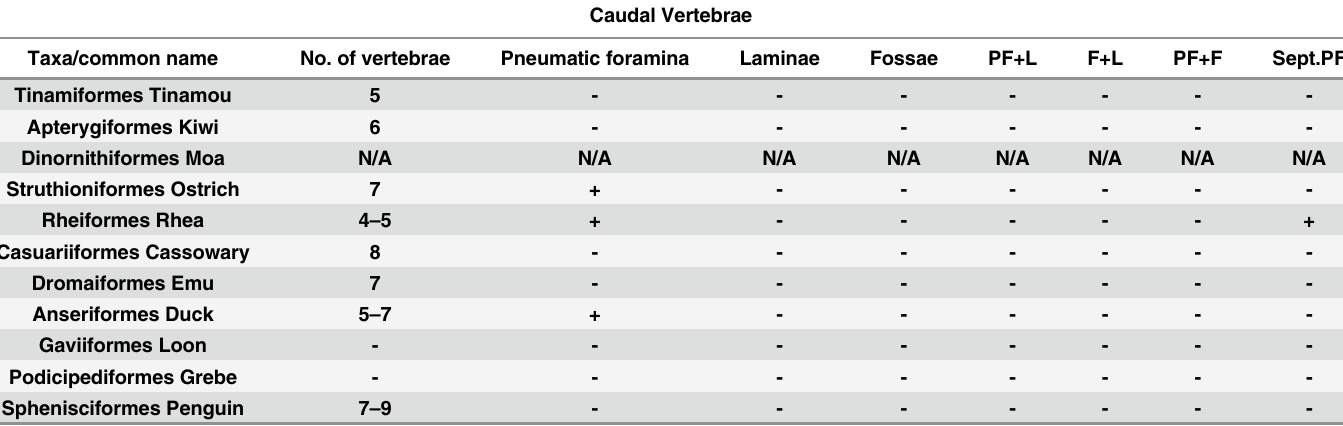
Table 5. Distribution of pneumatic elements of caudal column per taxon. Presence (+) and absence (-) of pneumatic characters found on the caudal vertebrae from specimens of the 11 taxa studied. The penguin with the pneumatised vertebrae is Pygoscelis papua (NHMUK unregistered). For more details see S1 Table and S3 – S13 Tables. Abbreviations: PF, pneumatic foramina; F, fossae; L, laminae; Sept., septated; N/A,